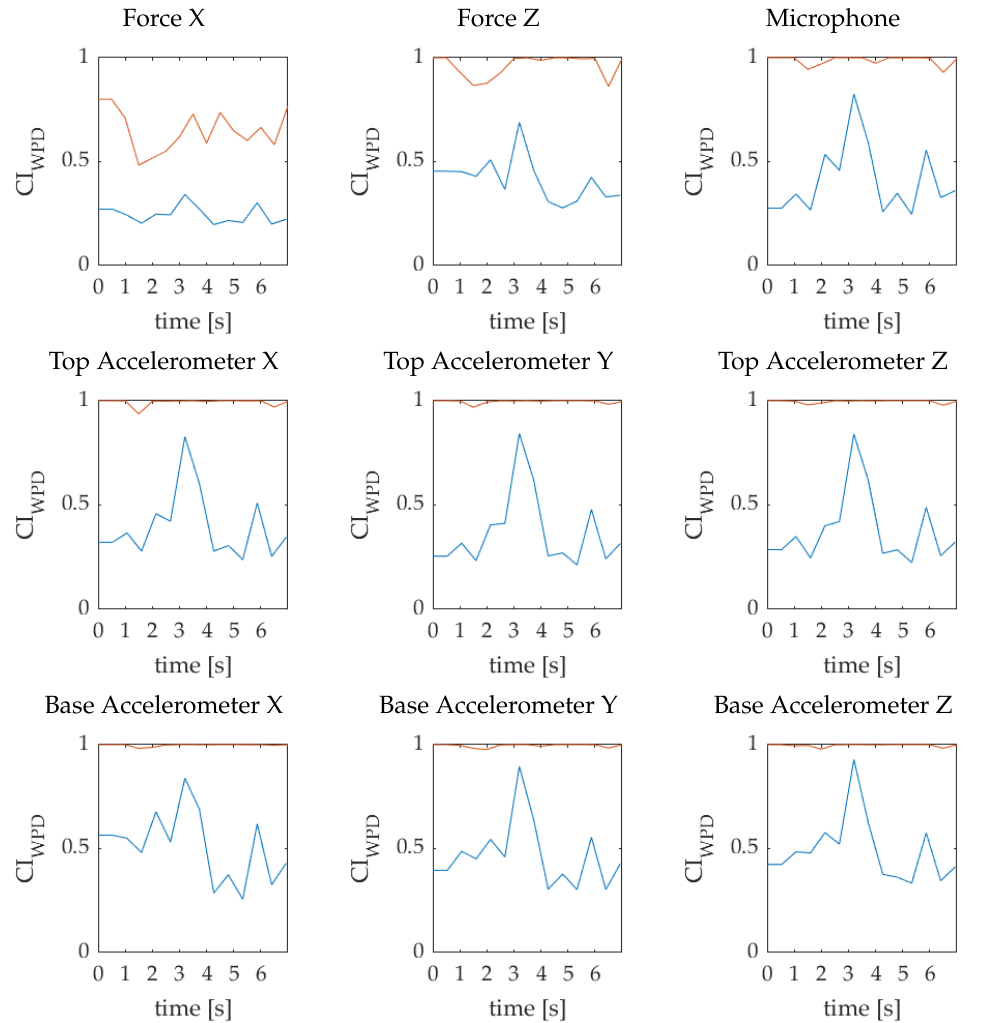
Figure 10. Wavelet chatter indices: blue “always stable” process—Red “always in chatter”